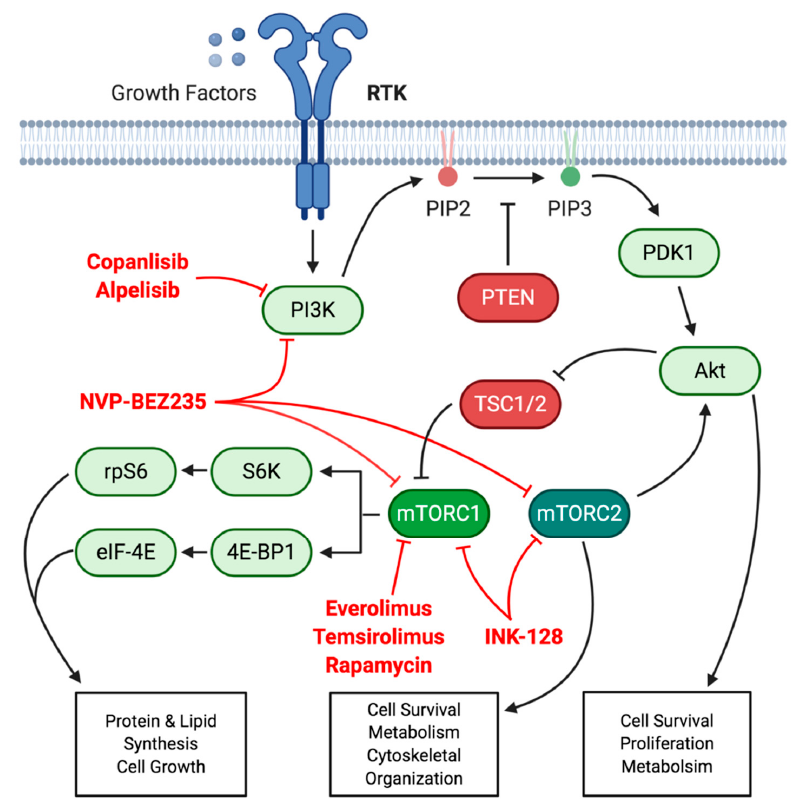
Figure 1. PI3K/Akt/mTOR signaling axis. Growth factors bind to cognate RTK (receptor tyrosine kinase), resulting in downstream phosphorylation and activation of PI3K (phosphatidylinositol 4,5-bisphosphate 3-kinase). PI3K phosphorylates PIP2 (phosphatidylinositol 4,5-bisphosphate) to PIP3 (phosphatidylinositol 1,4,5-triphosphate). Conversion from PIP3 back to PIP2 is catalyzed by tumor suppressor PTEN (phosphatase and tensin homolog). Increased PIP3 facilitates activation of PDK1 (phosphoinositide-dependent kinase-1) and Akt to promote cell survival and proliferation. Part of Akt activity is through downstream activation of mTOR (mammalian target of rapamycin), exists in the context of two complexes (mTORC1 and mTORC2) with different binding partners. mTORC1, through the activation of downstream effectors, facilitates cell growth through promoting protein and lipid synthesis. The activity of mTORC1 is derepressed through inactivation of TSC1/2 by Akt. Indicated in red are several pharmacologic inhibitors of this signaling axis either in clinical practice or currently under investigation. S6K, S6 serine/threonine kinase; rpS6, ribosomal protein S6; 4E-BP1, 4E-binding protein 1; eIF-4E, eukaryotic translation initiation factor